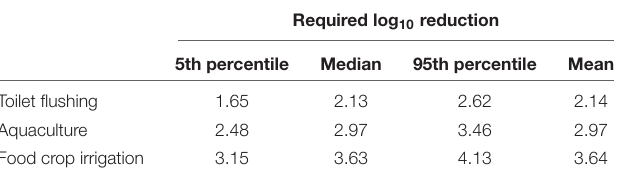
TABLE 3 | Required log 10 reduction of HAdV40/41 to achieve the US EPA annual infection risk benchmark of 10 − 4 per person per year as predicted by either crAssphage or